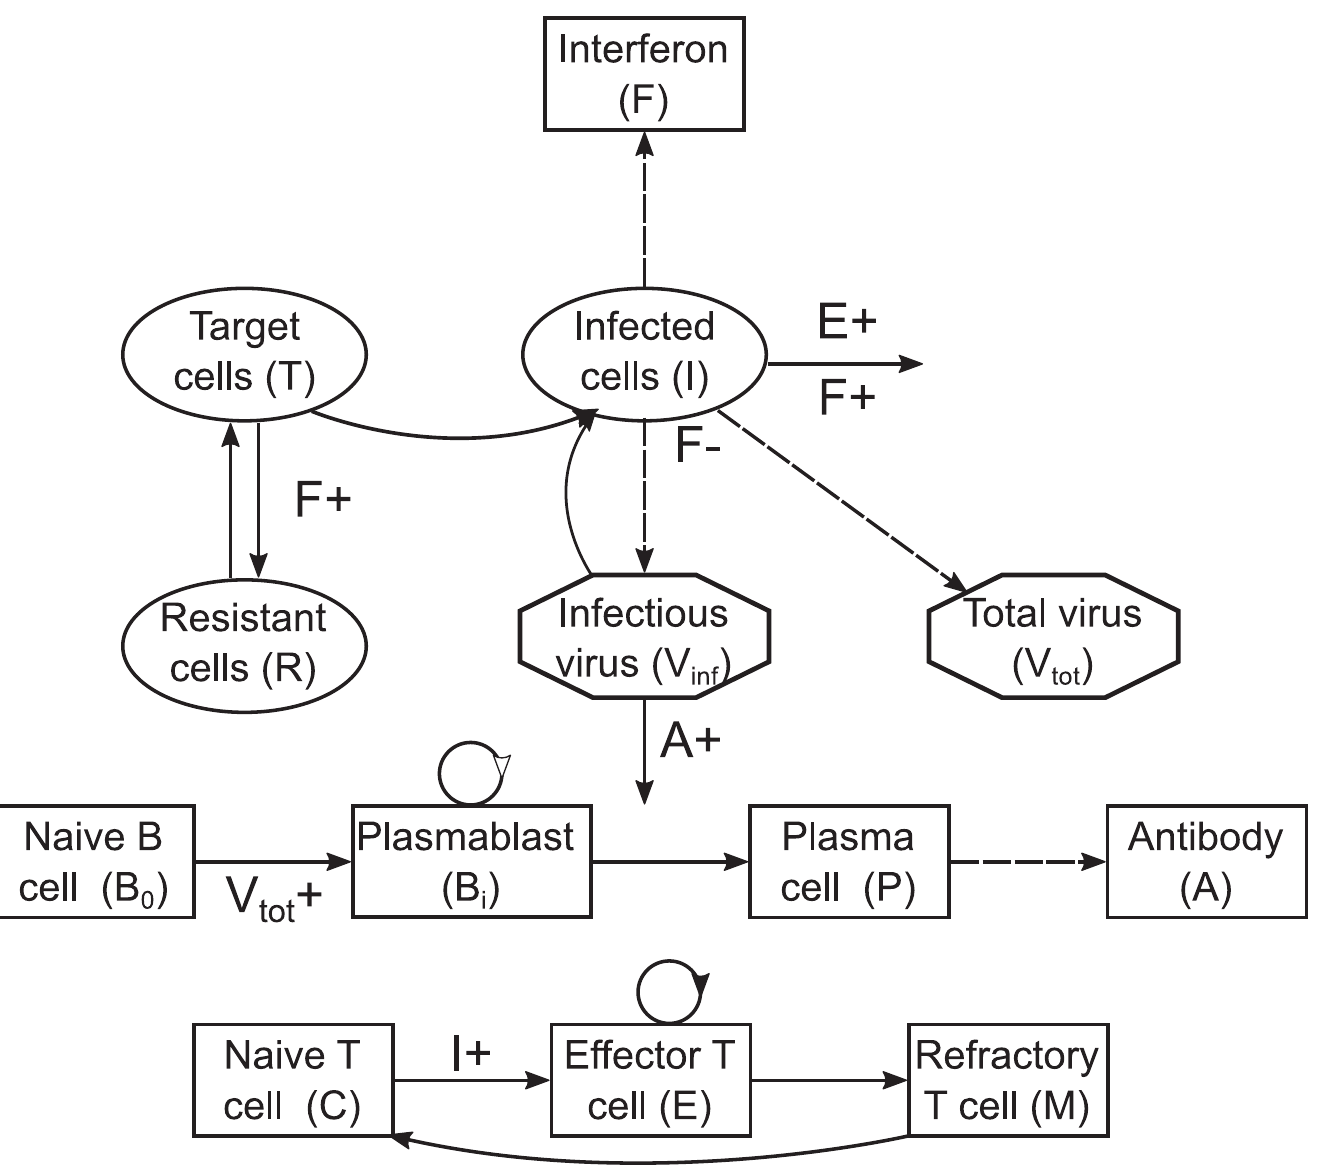
Fig 6. The within-host influenza model for a single strain. (Top) Viral dynamics and innate immune response; (middle) humoral adaptive immune response; (bottom) cellular adaptive immune response. Solid arrows indicate transitions between compartments or death (shown only for immune-enhanced death processes); dashed arrows indicate production; plus signs indicate an increased transition rate due to the indicated